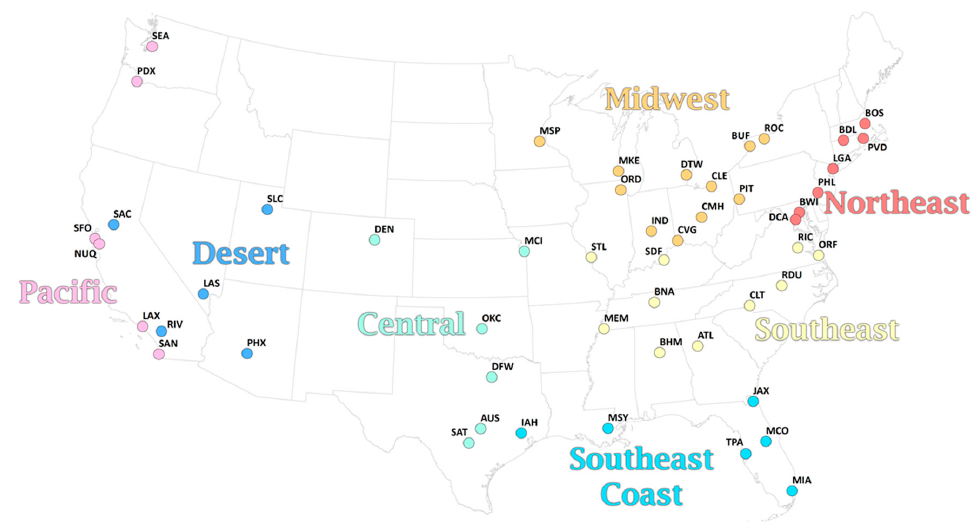
Figure 1. Map of the metropolitan areas in this study and their respective regional association.